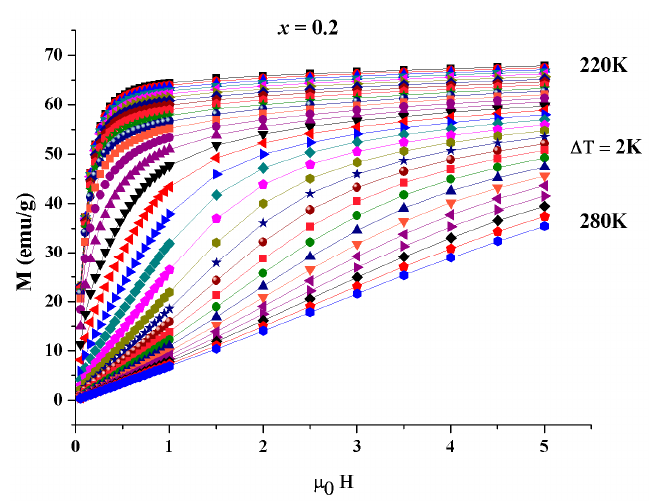
Figure 4. Temperature ( T ) dependence of the magnetization M (T, µ 0 H ) measured at different magnetic applied field ( µ 0 H ) for the La 0.8-x (cid:0) x Ca 0.2 MnO 3 ( x = 0; 0.1 and x = 0.2) compounds annealed at 973 K.